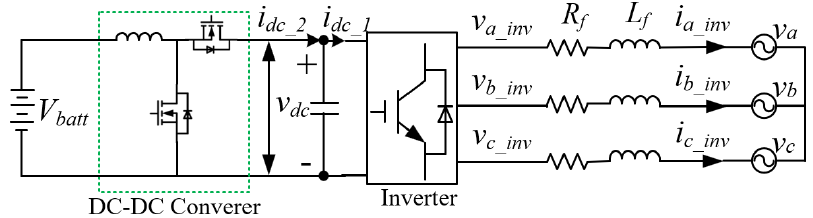
Figure 3. Schematic of an inverter connected to the grid via LCL